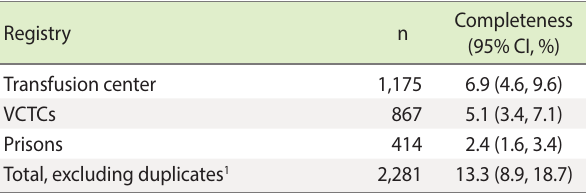
Table 3. Completeness of the detection of HIV-positive individuals using the 3